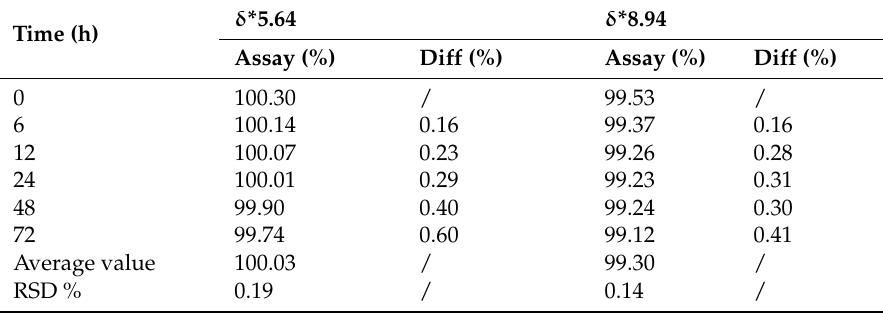
Table 3. Stability results of Orlistat purity